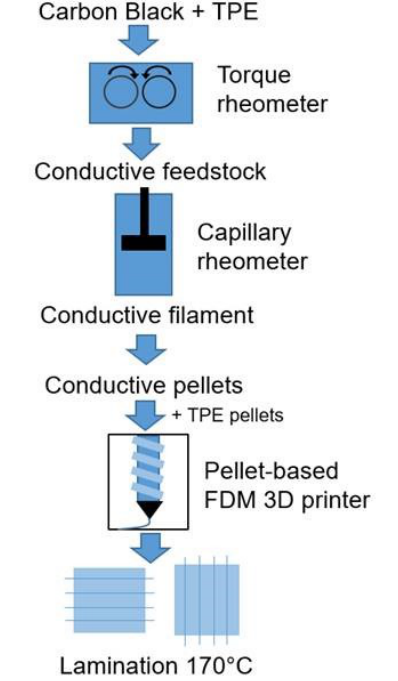
Figure 2. Fabrication steps of the sensor fiber